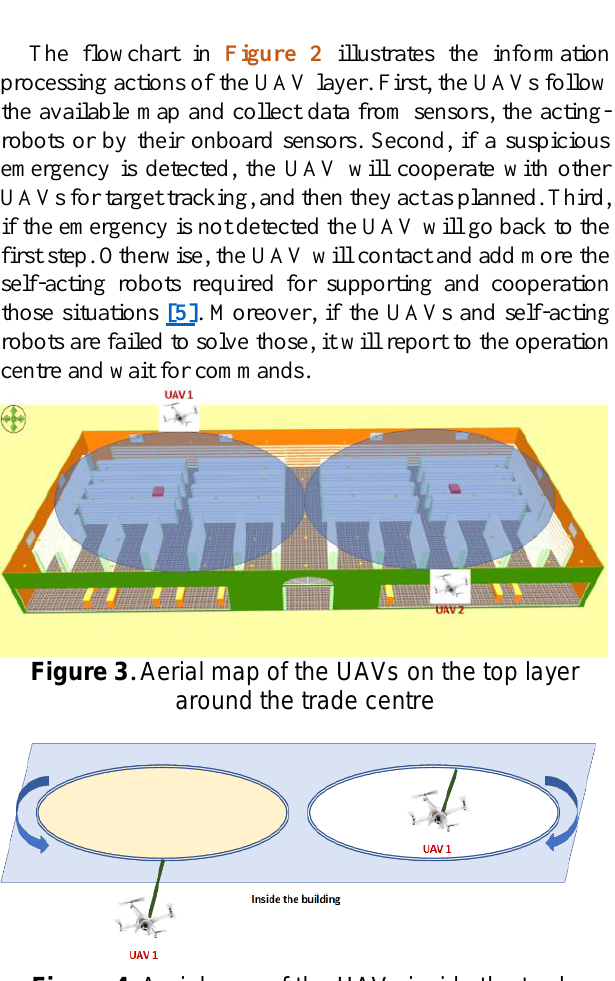
Figure 4 . Aerial map of the UAVs inside the trade centre